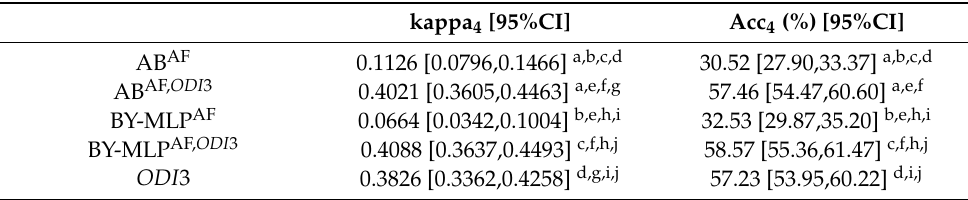
Table 4. Global diagnostic metrics of the proposed models and ODI